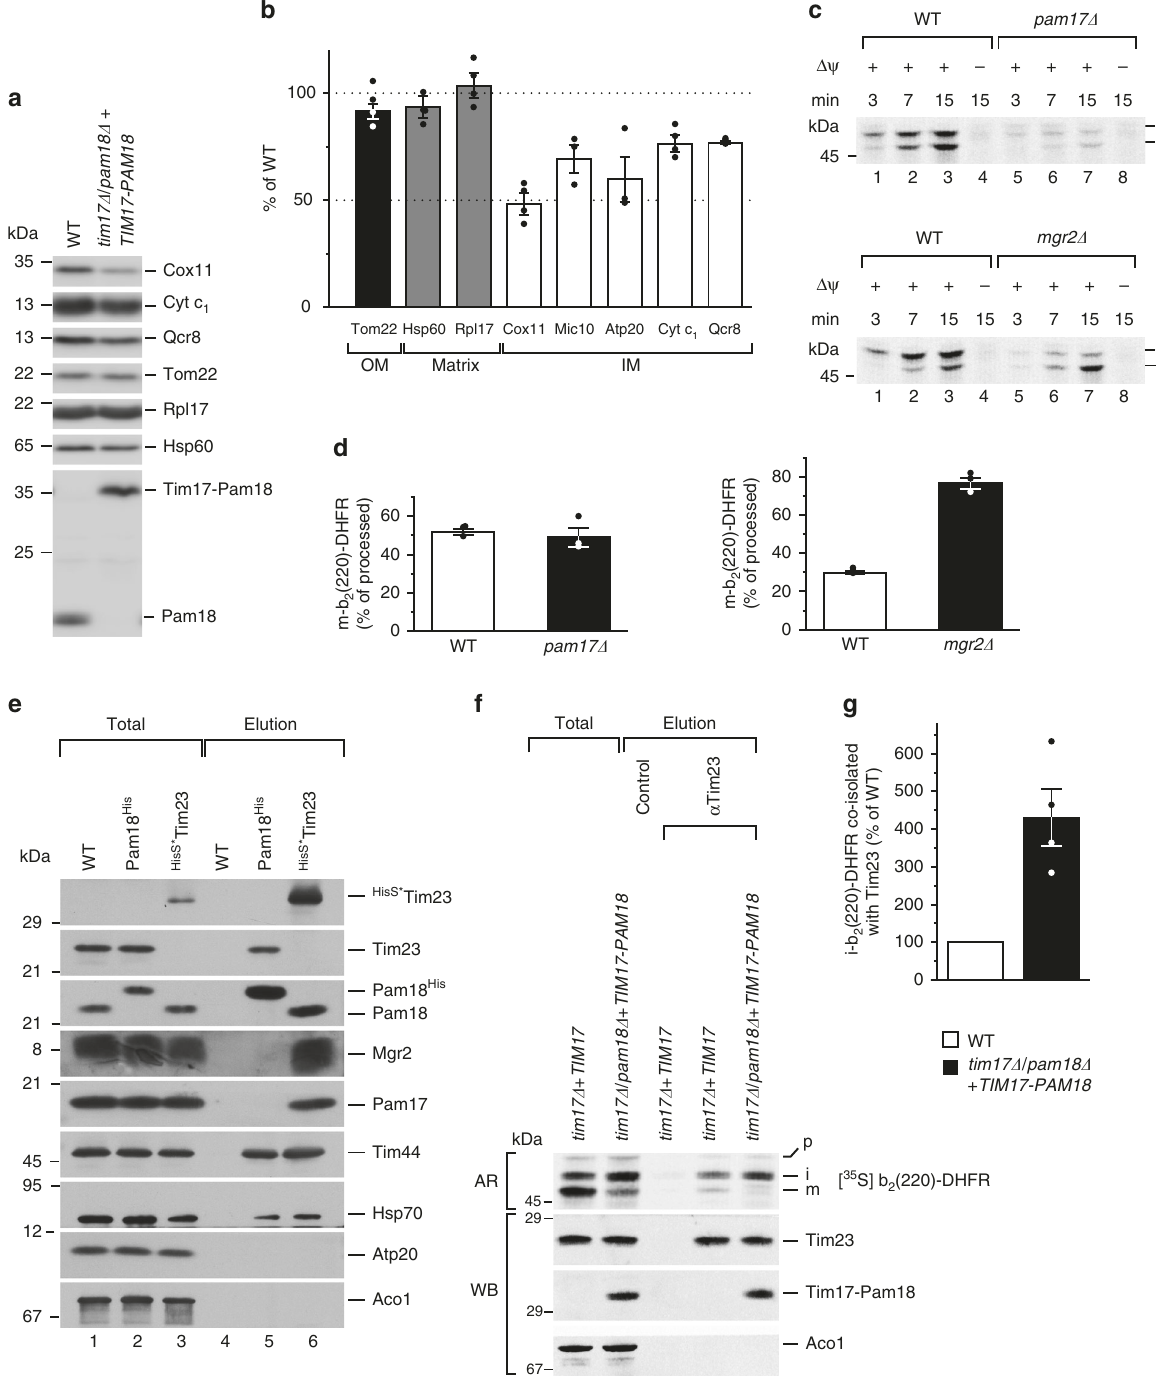
NATURE COMMUNICATIONS| (2018) 9:4028 |DOI: